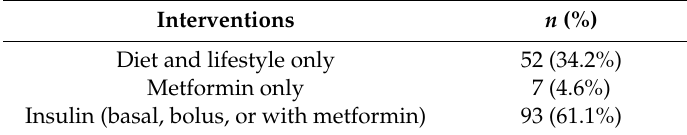
Table 2. Interventions reported for women diagnosed with